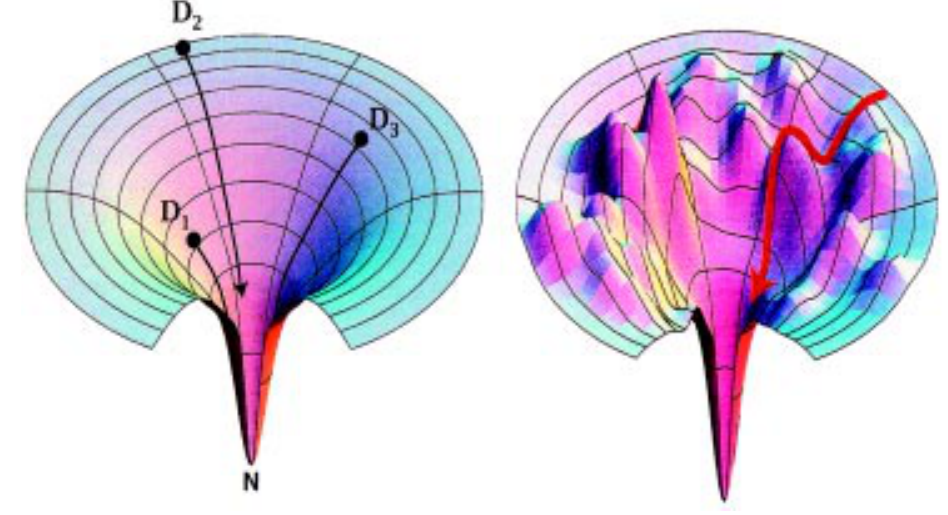
Figure 5 - Three-dimensional rep- resentation of folding funnels (see text) according to Dill and Chan (47; reproduced with per-